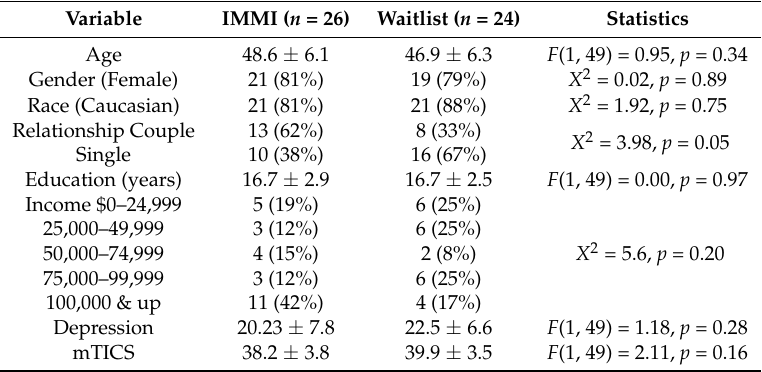
Table 1. Participant demographic